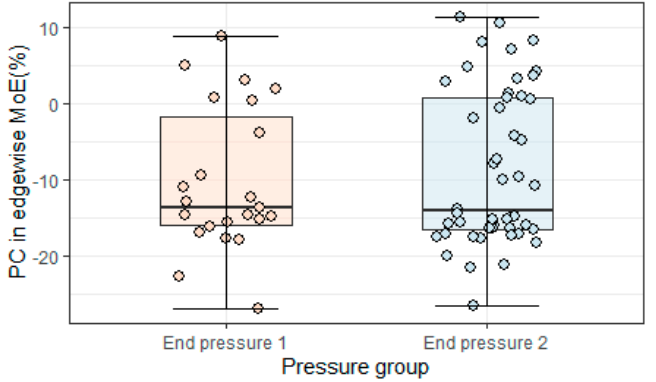
Figure 13. Percentage changes (PCs) in edgewise MoEs of boards under different pressure